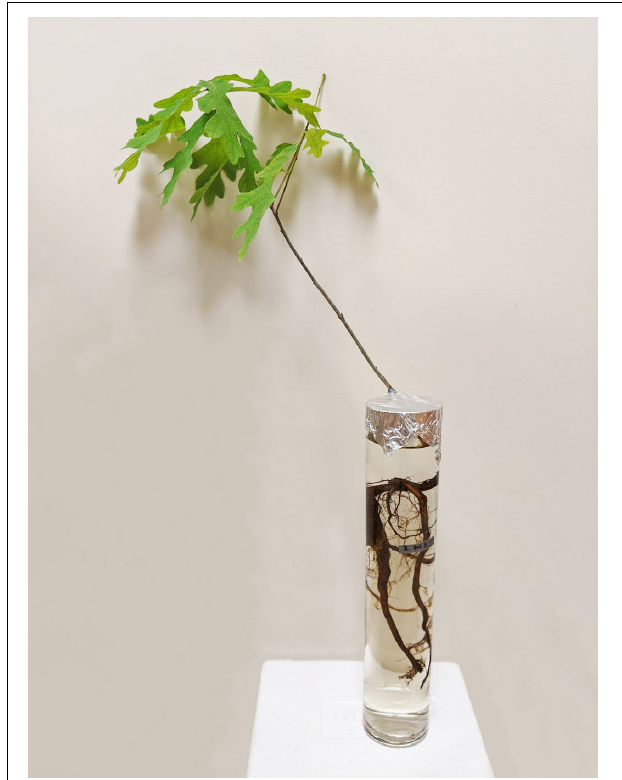
FIGURE 1 | dsRNA solution was pipetted onto wall of glass assay cylinder for each treatment seedling. Containers were filled with 1.8 mL dd H 2 O after which seedlings were submerged to the root